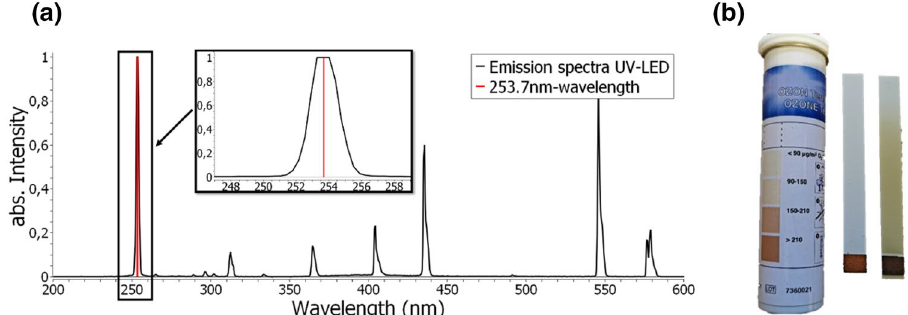
Fig. 2 a Emission spectra of the used UV lamps. b Colour change of the ozone test swipe with the colour scale from white to